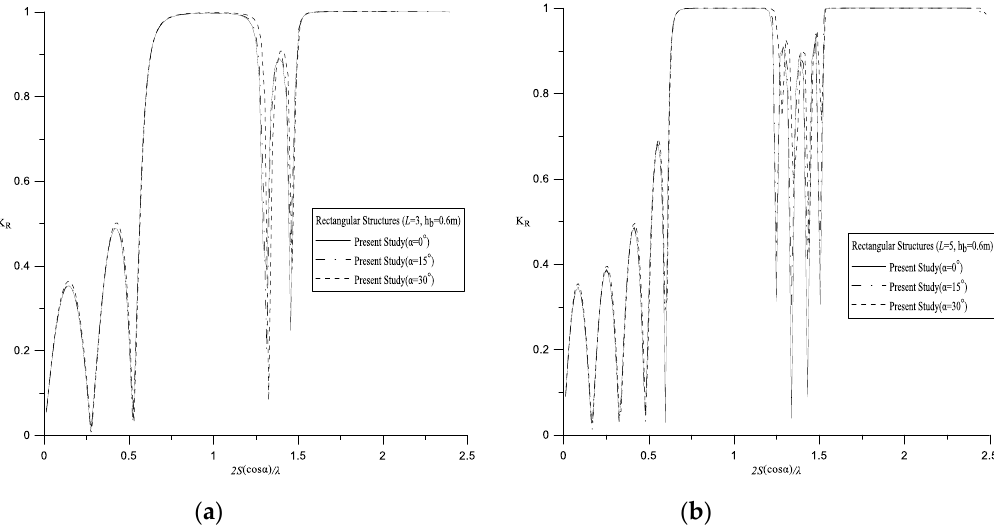
Figure 14. The reflection coefficients for Bragg reflections by periodic rectangular surface-piercing structures of di ff erent numbers ( a ) L = 3 and ( b ) L = 5 over periodic parabolic